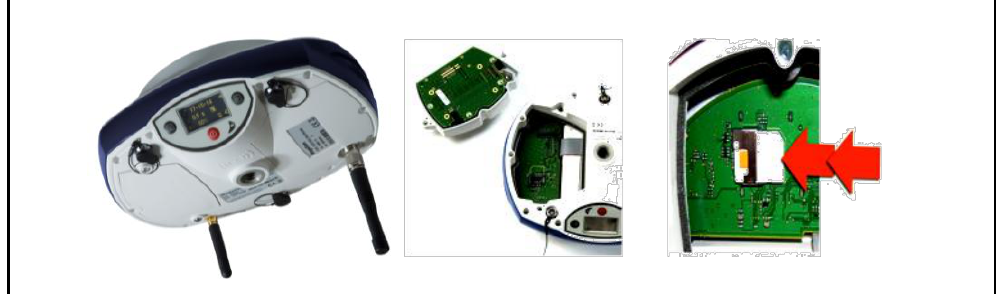
Figure 4. Promark500 GPS receiver and installing SIM